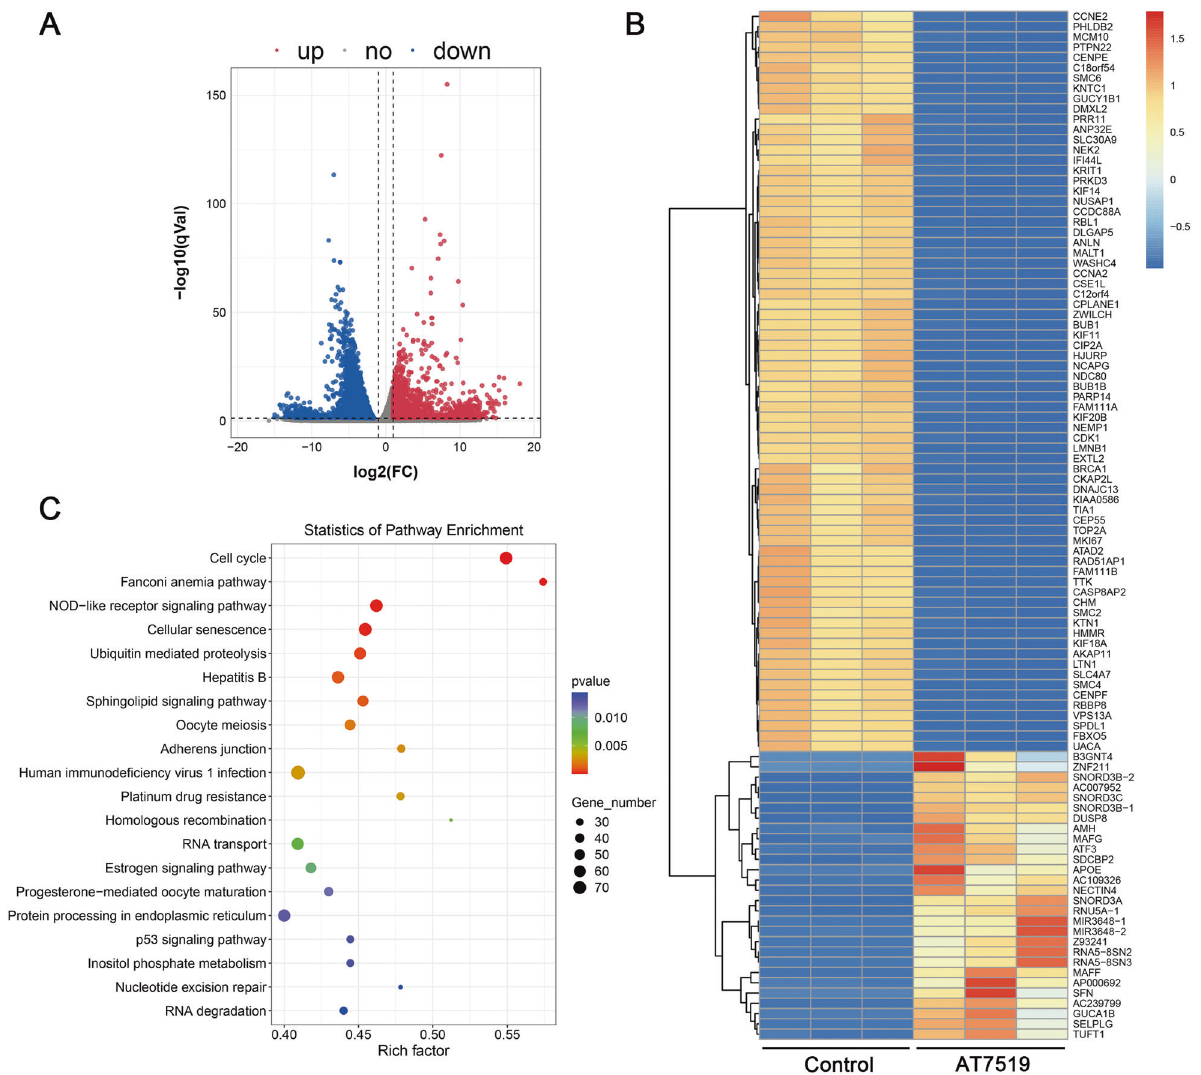
Fig. 2 Differential gene expression and pathway enrichment analysis of glioblastoma cells treated with AT7519. A , B U87MG cells were treated with AT7519 for 48 h for RNA sequencing, and a volcano plot and heatmap of differential expression were obtained by analysis (upregulated genes are in red; downregulated genes are in blue; nonregulated genes are in gray (|log2FC | ≥ 1 and q -value ≤ 0.05). C KEGG pathway analysis of differentially expressed genes. The volcano map was drawn based on R (https://www.r-project.org/) on the OmicStudio platform (https://www.omicstudio.cn/tool). KEGG pathway analyses were performed using the OmicStudio tools at https://